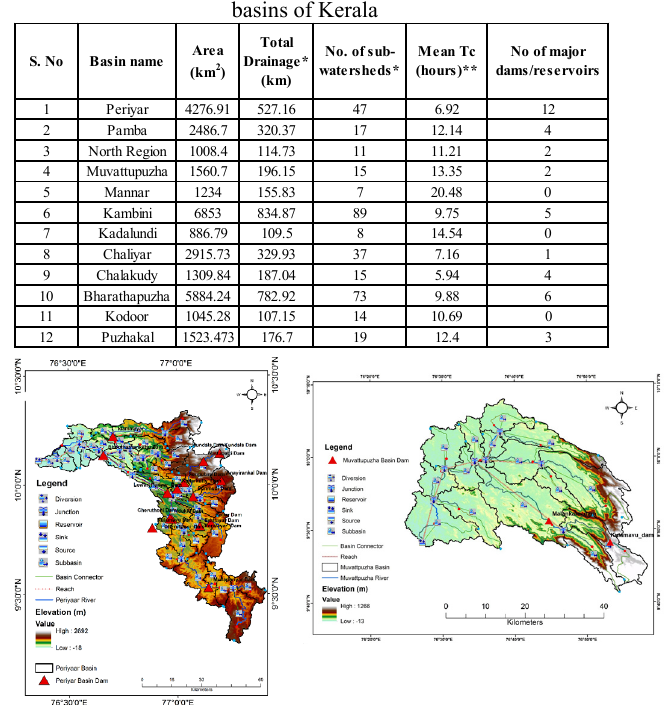
Table 2 : Area and drainage details of major flood affected